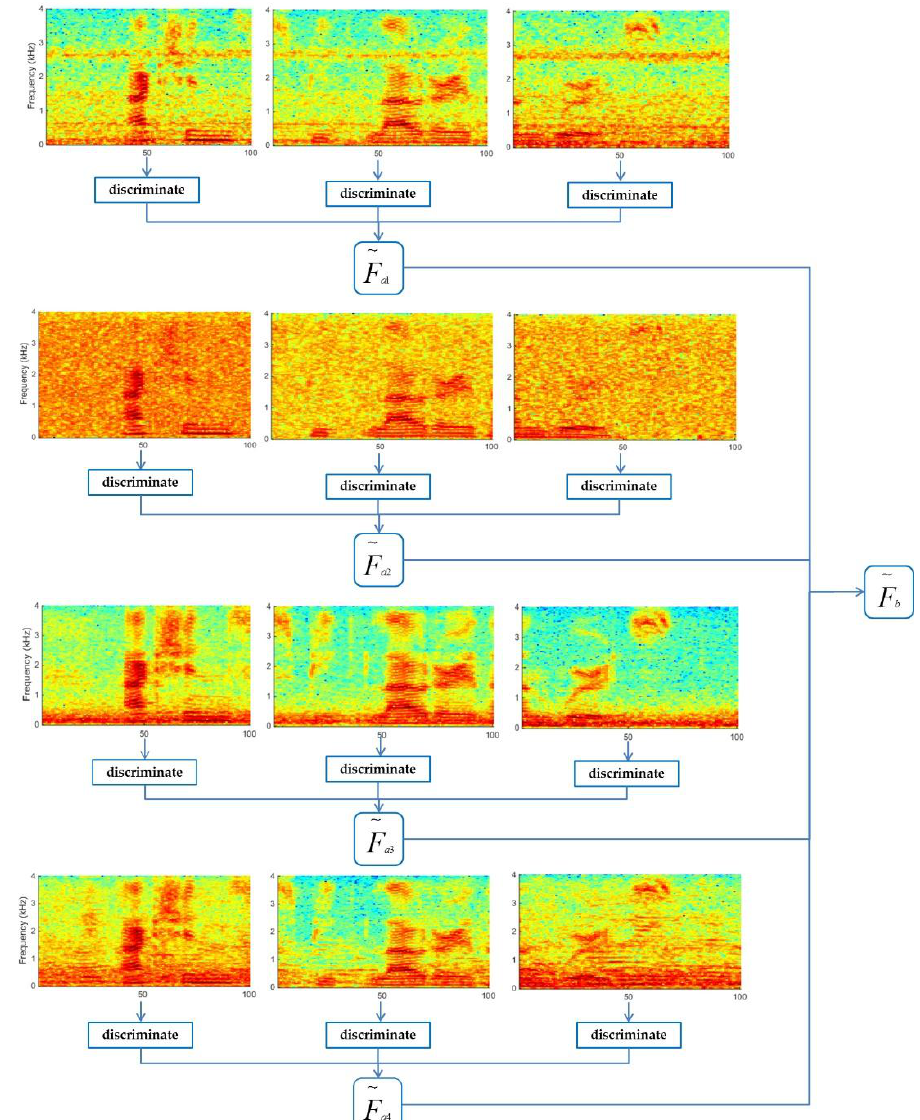
Figure 6. An illustration of the bagging approach used. 𝐹̃ 𝑎1 denotes the bagging result of the three segments from the same utterance. 𝐹̃ 𝑎1 to 𝐹̃ 𝑎4 denote bagging results after adding four different kinds of noises to the original utterance.